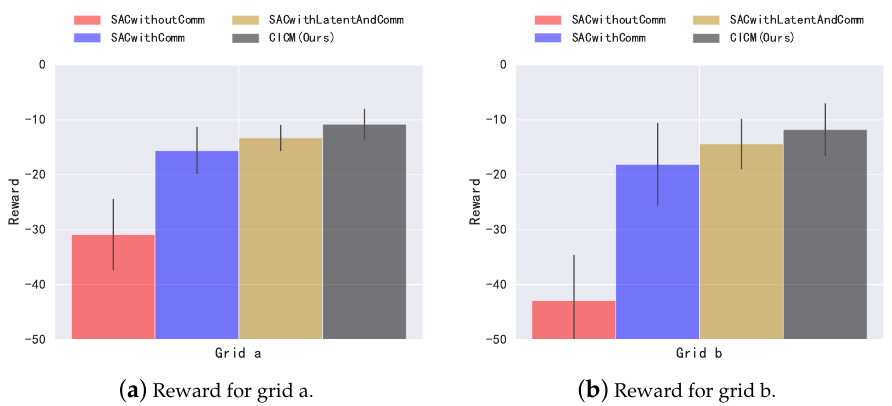
Figure 6. Return in the power grid environments. Error bars are one standard deviation. The communication penalty is set to r comm-penalty = −